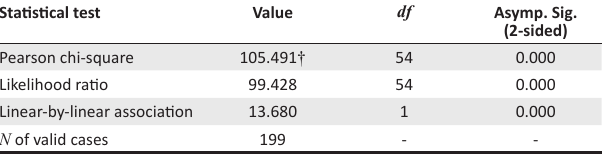
TABLE 3b: Correlation between educational level and influence on performance and career as in Table 3a. Statistical